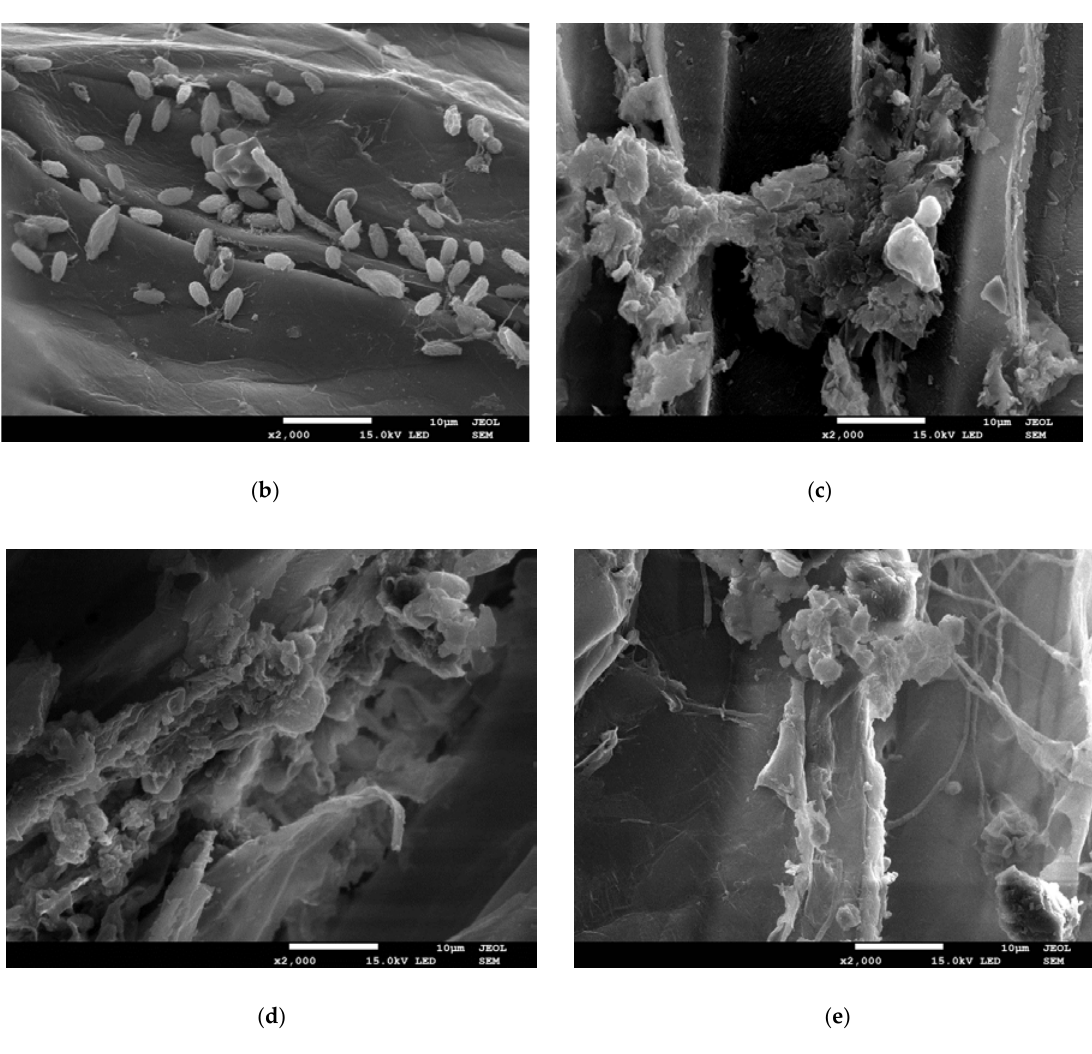
Figure 2. Scanning electron microscopy (SEM) micrographs of the uncolonized loofah sponges ( a ), that were colonized by Bacillus thuringiensis B1(2015b) ( b ), microflora from the Imhoff tank at the bottom ( c ), in the middle ( d ) and at the top ( e ) of the trickling filter.